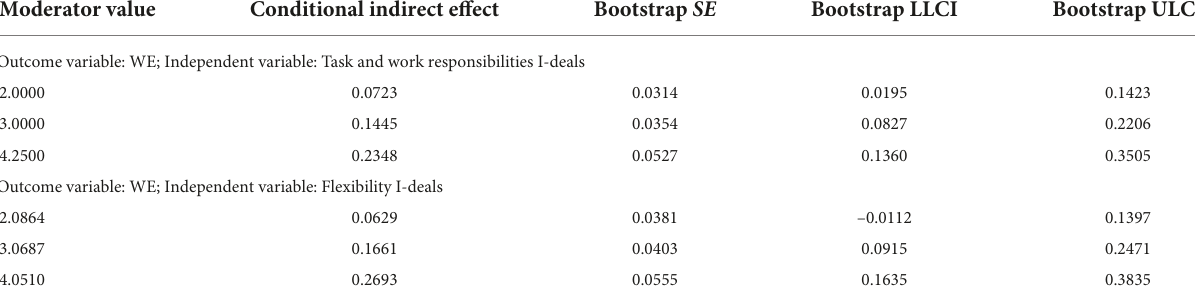
TABLE 7 Conditional indirect effect